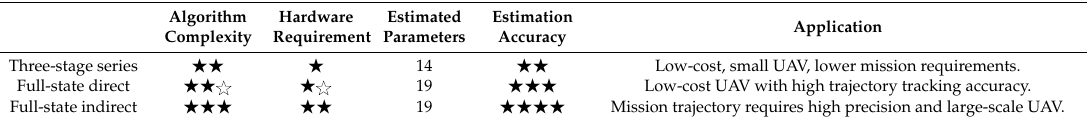
Table 3. Comparison of di ff erent state estimation